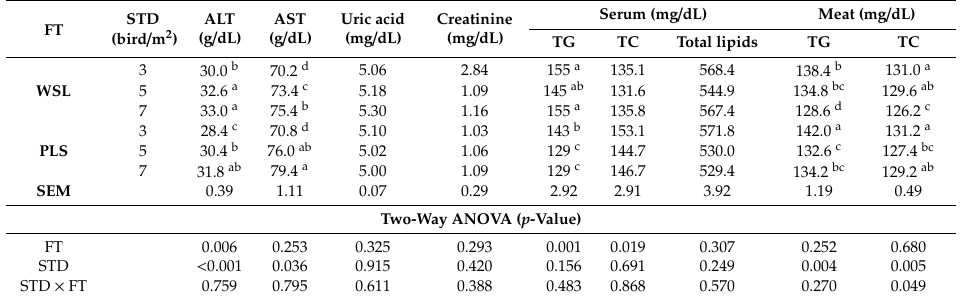
Table 4. E ff ects of stocking density (STD) and flooring type (FT) on blood biochemistry and meat cholesterol of Pekin ducks at 49 days of age.